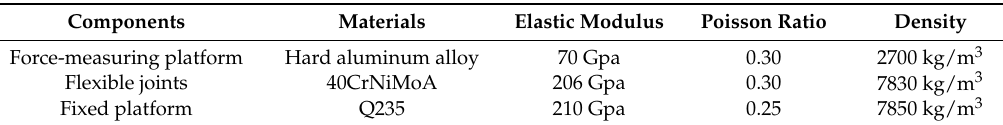
Table 1. Material properties of the sensor.